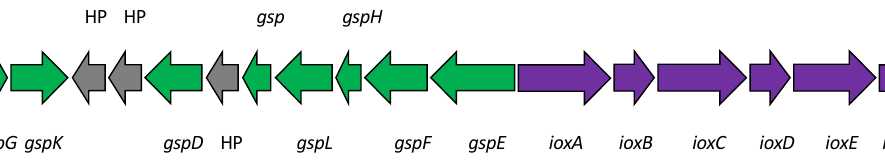
Figure 4. The putative iox gene cluster (purple) found in the draft genomes of Iodidimonas strains. IoxA is a multicopper oxidase and IoxB, IoxD, and IoxF are all homologs of the SCO1/SenC family protein. The functions of IoxC and IoxE are still unclear. Genes involved in the general secretion pathway ( gsp genes, green) are present in the flanking region of the iox gene cluster. HP, hypothetical proteins (gray).